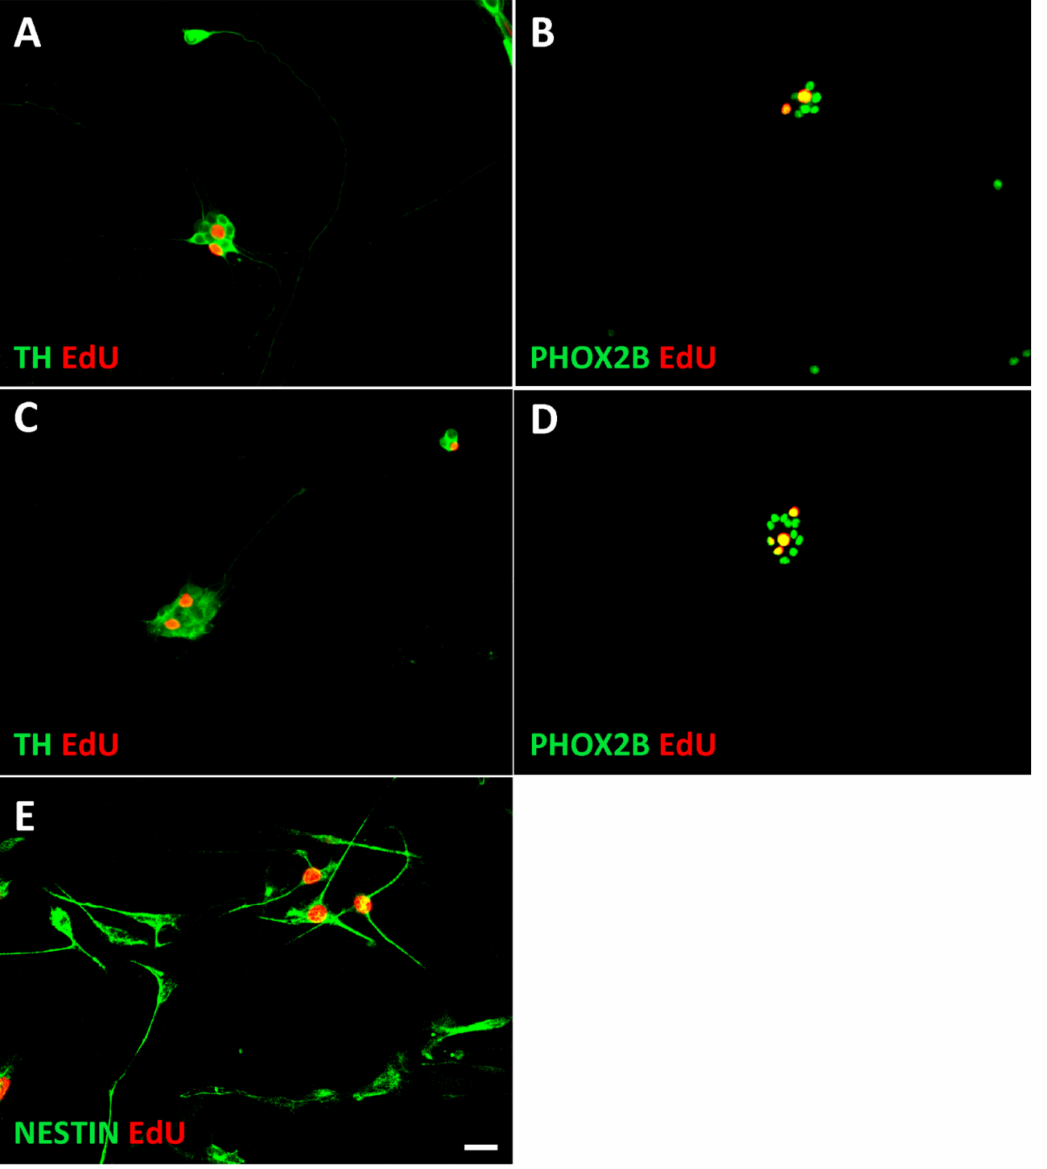
Figure 5. Identification of proliferating neuroblasts, chromaffin cells, and NESTIN-expressing cells. Proliferating cells were identified by a short 4 h EdU pulse, followed by immunostaining for PHOX2B, TH, or NESTIN combined with EdU-staining using the Click-iT protocol. Cultures of sympathetic neuroblasts ( A , B ), chromaffin cells ( C , D ), and Nestin-expressing cells (NECs) ( E ) are shown. For quantification PHOX2B/EdU rather than TH/EdU staining was used since nuclear staining resulted in better cell identification. Magnification bar, 60 µ